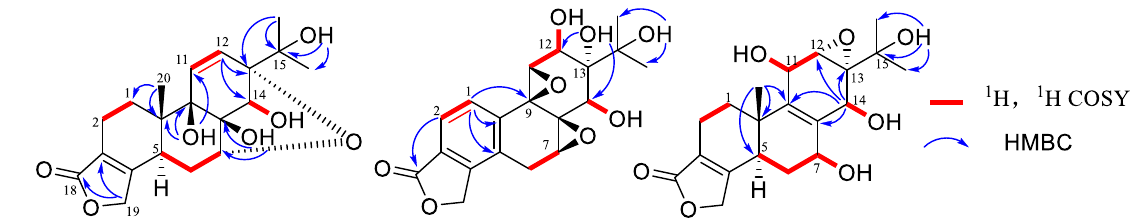
Figure 2. Key 1 H, 1 H COSY and HMBC correlations of compounds 1 – 3 .